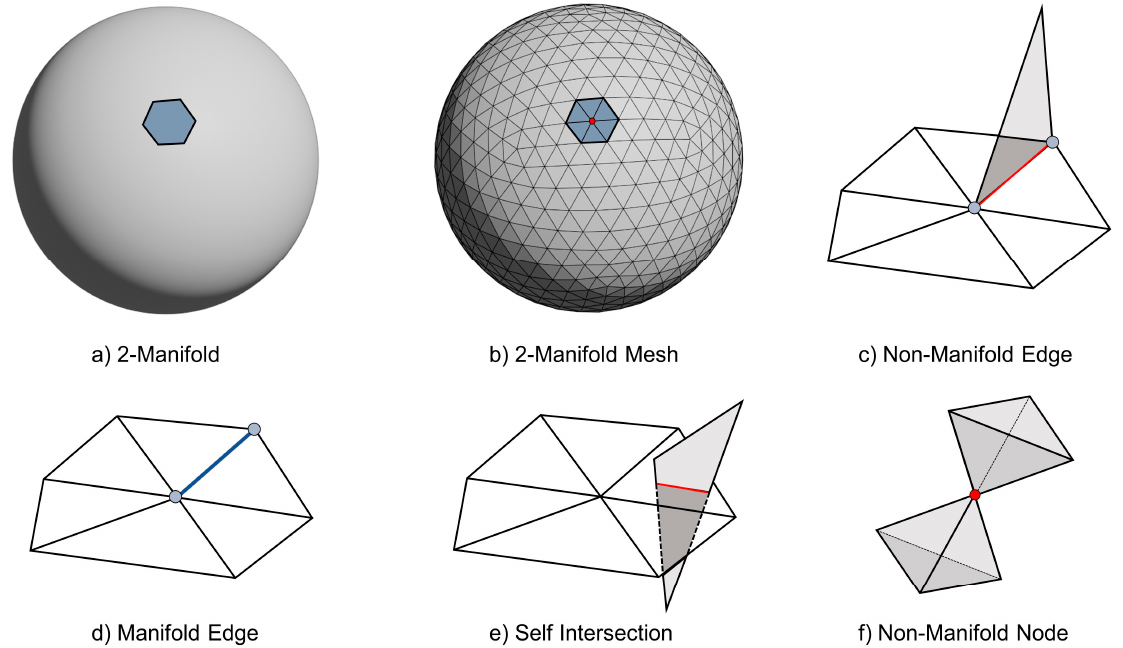
Figure 2. Visual definitions of 2-manifold surfaces and planar patches, modified after Bonneau et al. [50]; ( a ) A continuous 2-manifold sphere with an outlined neighbourhood which is homeomorphic to a Euclidean disk; ( b ) A similar 2-manifold surface mesh; ( c ) A non-manifold mesh edge; ( d ) A proper manifold mesh edge; ( e ) A non-manifold mesh self intersection; ( f ) A non-manifold node connecting two tetrahedra.